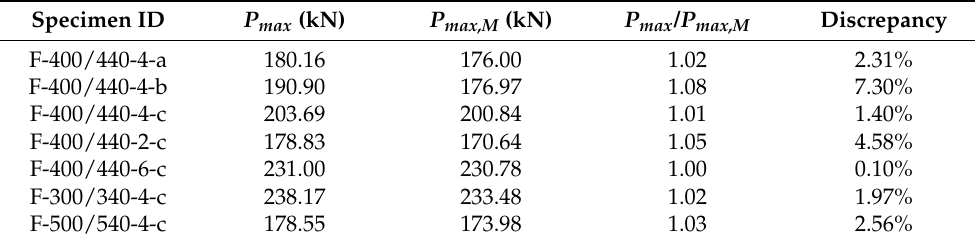
Table 6. Comparison between the test value and the simulation value of peak loads. Specimen